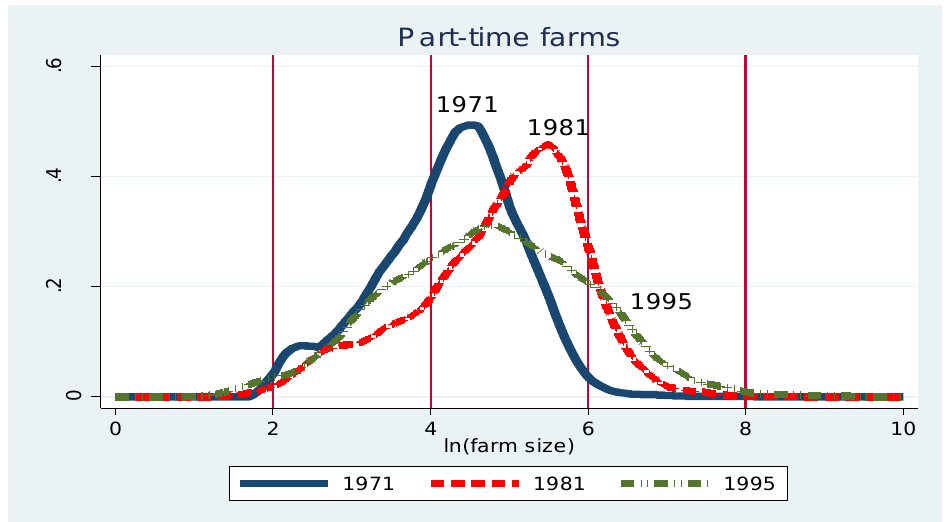
Figure 1. Changes in the farm size distribution by full-time/part-time status.